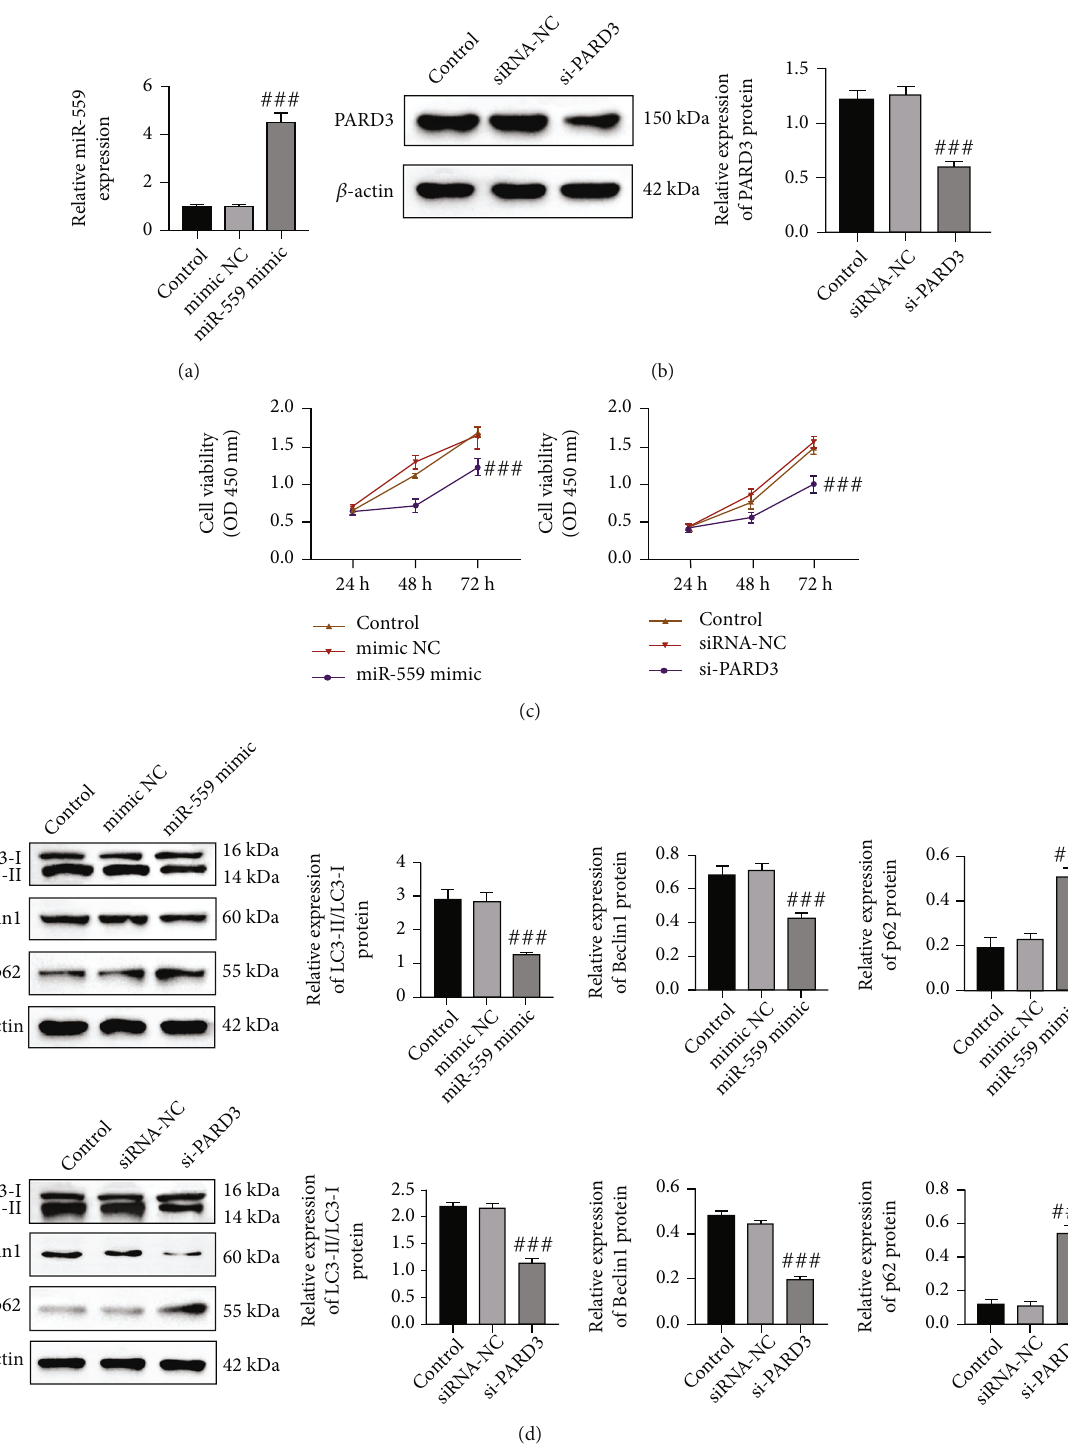
Figure 2: miR-559 overexpression or PARD3 silencing inhibited the proliferation and autophagy of Huh-7 cells. Huh-7 cells were transfected with miR-559 NC/mimics or si-RNA NC/PARD3 for 24h. (a) The relative expression of miR-559. (b) The relative protein expression of PARD3. (c) Cell viability was detected by the CCK8 assay. (d) The relative protein levels of LC3-II/I, Beclin1, and p62. The values were obtained from three independent experiments and shown as mean ± SD . ### p < 0 : 001 , compared with mimic NC or